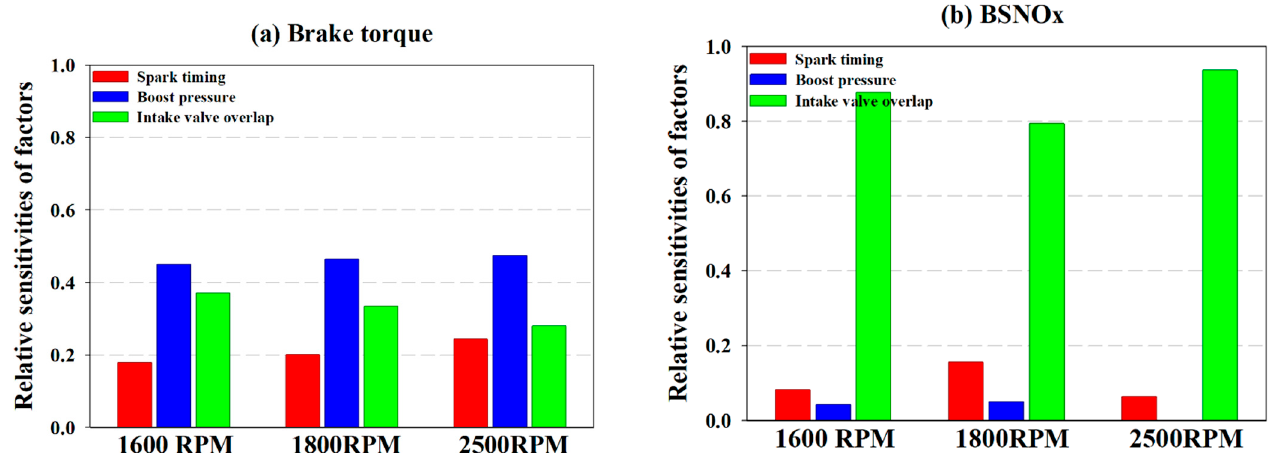
Figure 11. ( a ) Torque sensitivities of the operation parameters. ( b ) NOx sensitivities of the operation parameters.